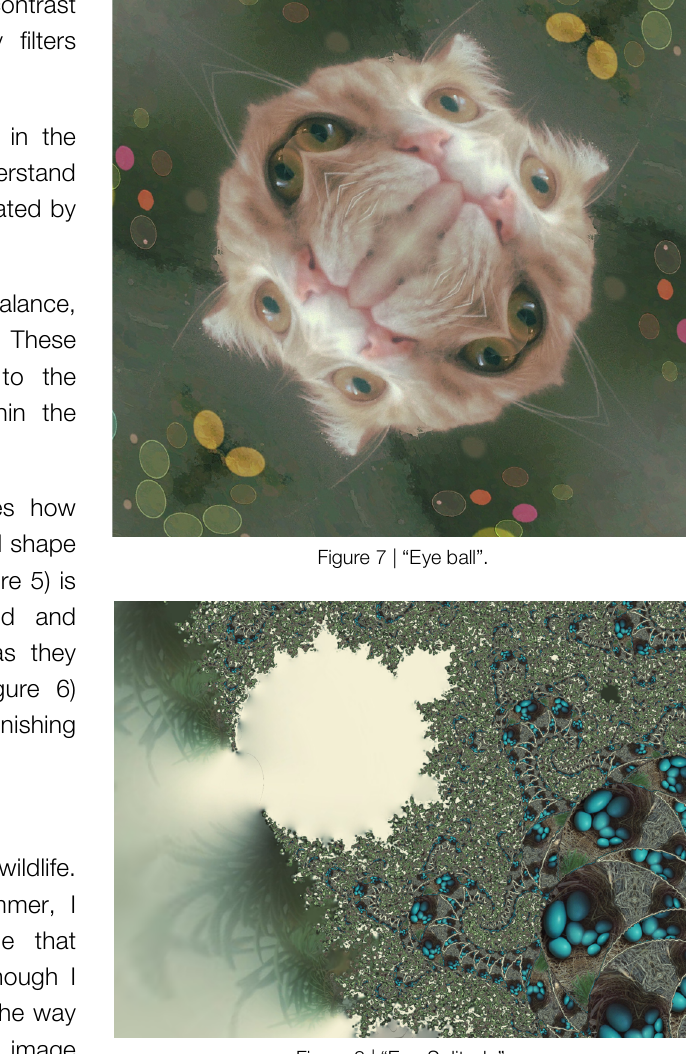
Figure 8 | “Egg Solitude”.